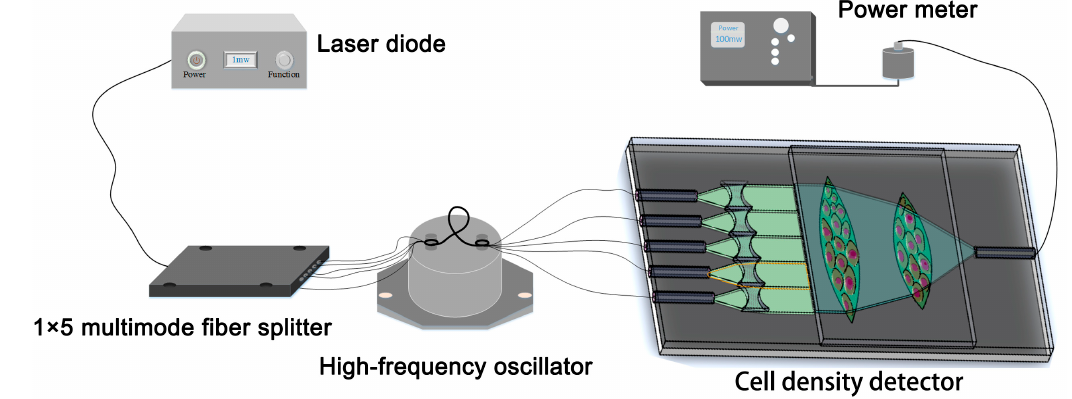
Figure 10. Experimental setup of the cell density test.